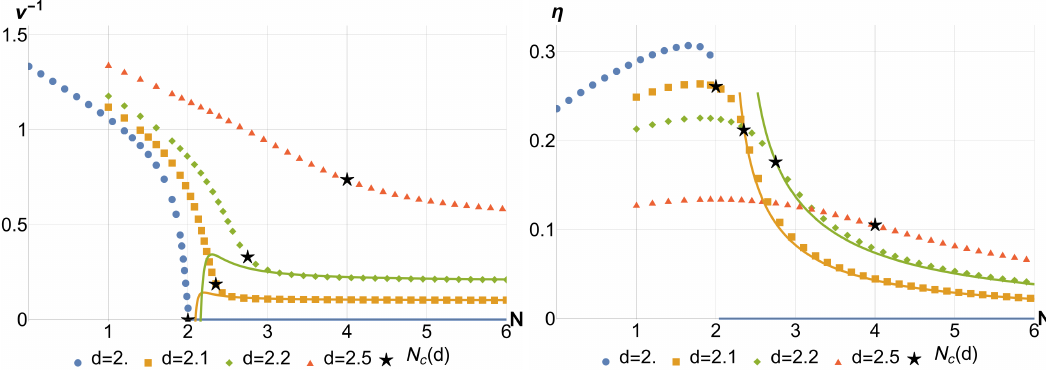
Figure 6: The critical exponents ν − 1 and η as functions of d for a sequence of values of N . In particular, for N = 2 we find η ( d → 2 + , N = 2 ) approaching the value ≈ 0.27 with a singular first derivative.